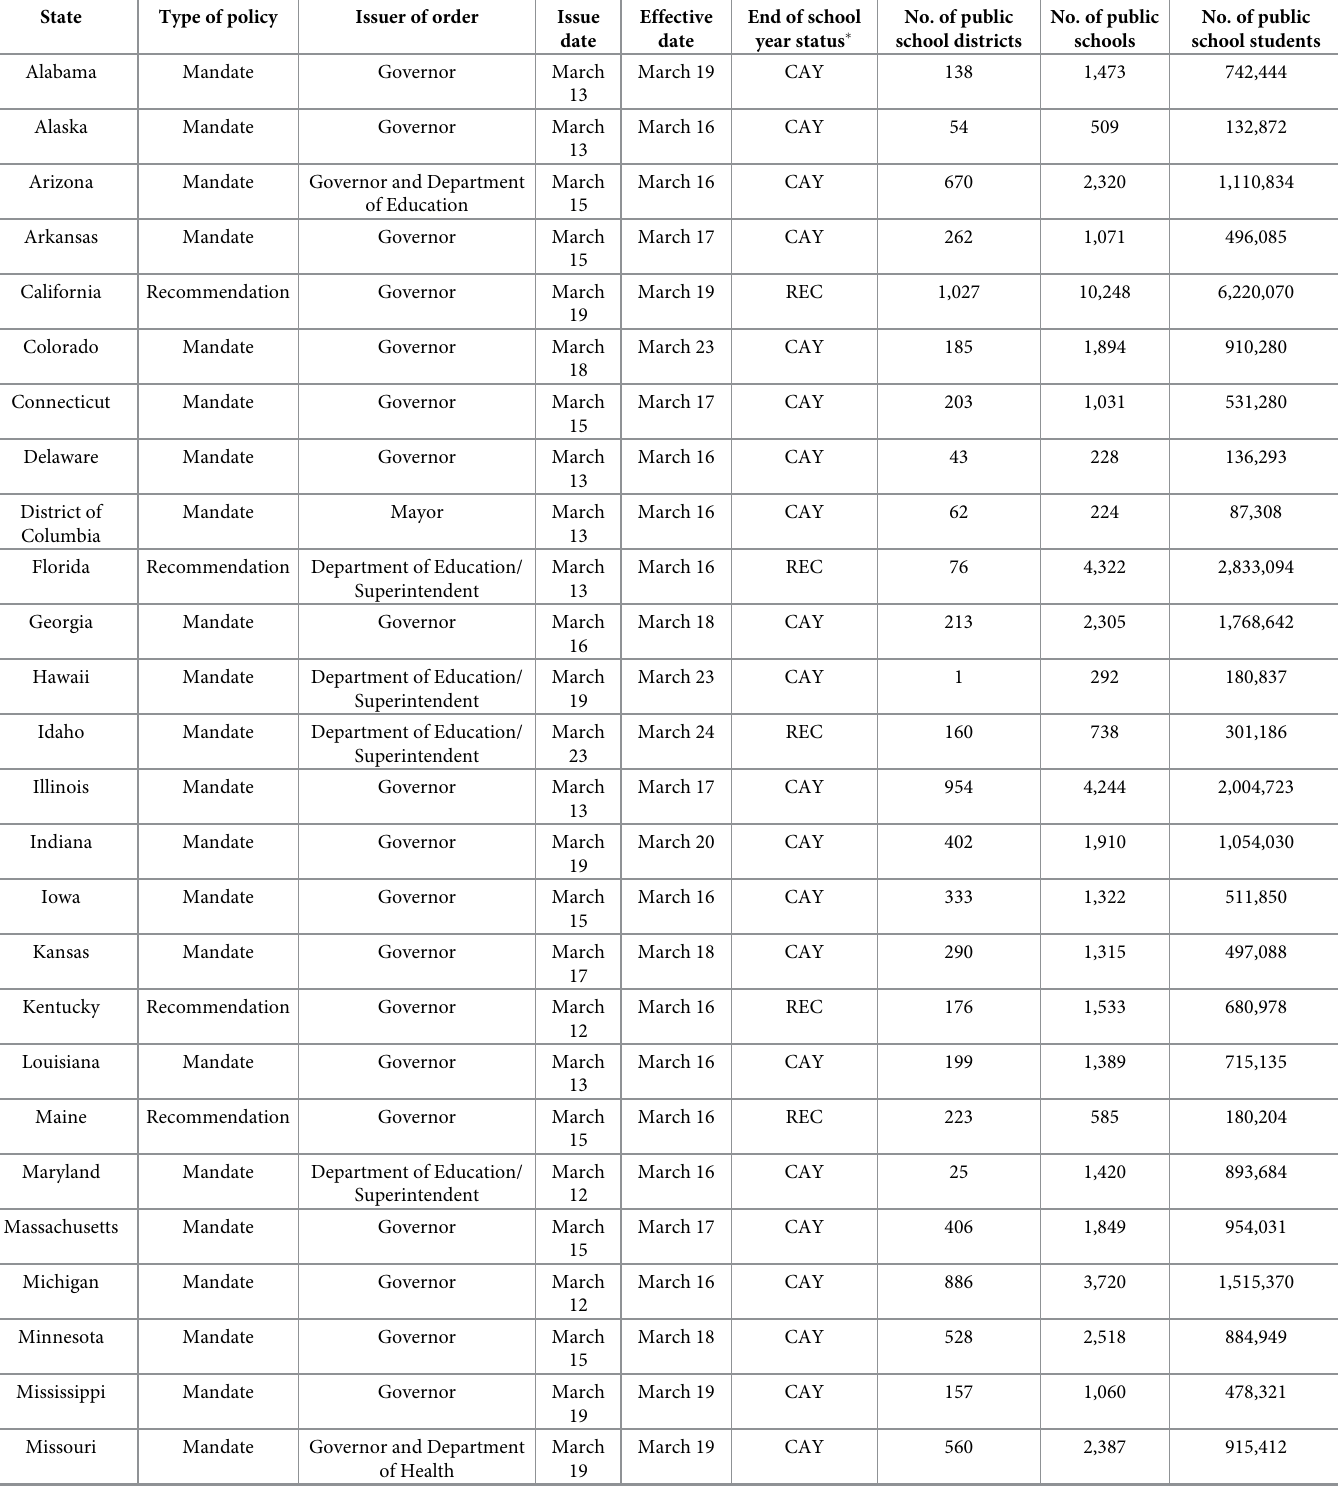
Table 1. Characteristics of statewide school and district closures during the coronavirus disease 2019 pandemic—United States, March 12–June 30,